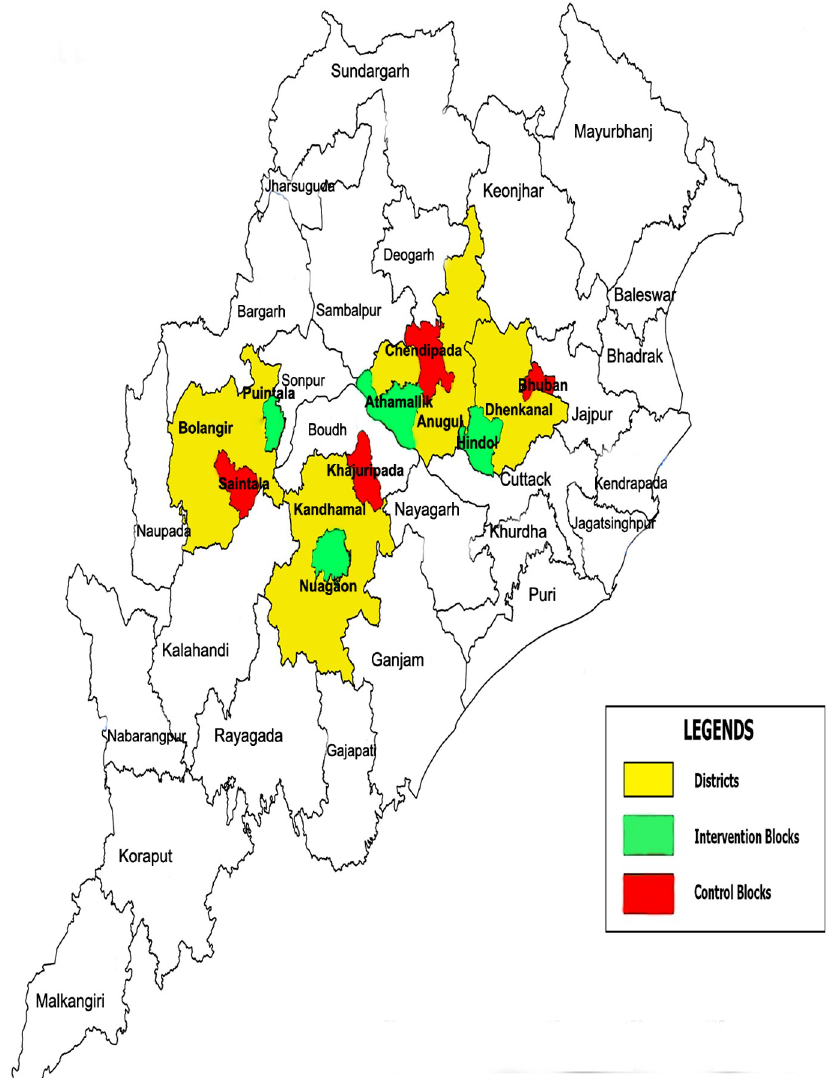
Fig 1. Map of Odisha with the CCMP intervention and control